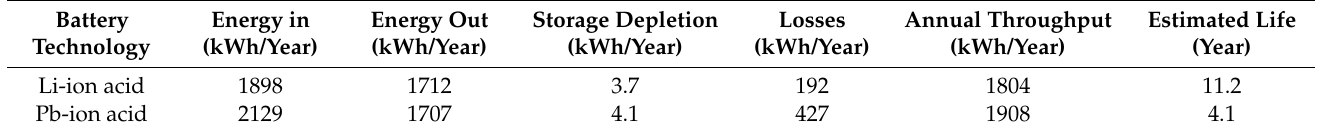
Table 8. Pb-acid vs. Li-ion battery technology in reference to techno-economic analysis